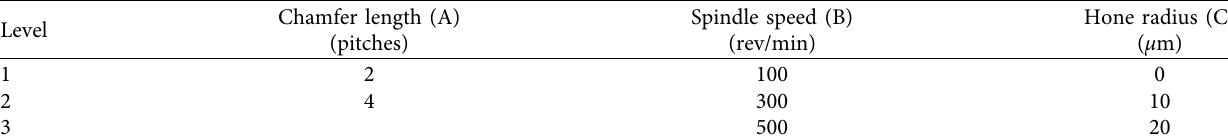
Table 4: Factors and